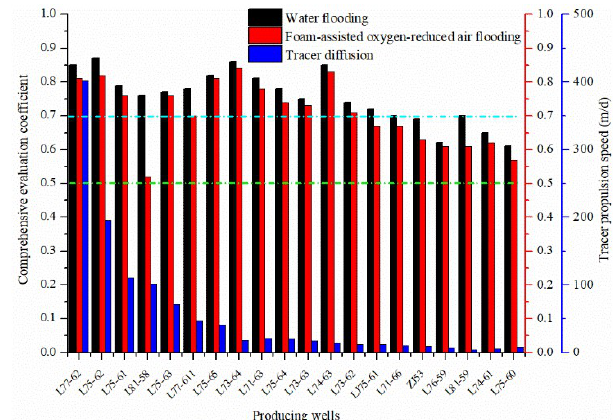
Figure 4. Identification results of the channeling channels of the production wells in the water flooding and FAORAF stages.